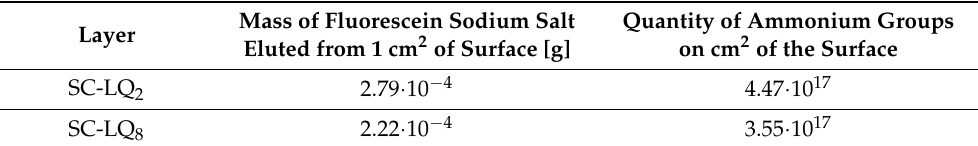
Table 1. Mass of fluorescein sodium salt eluted from 1 cm 2 of surface and quantity of ammonium groups introduced to P(DMAEMA-co-OEGMA-OH) star